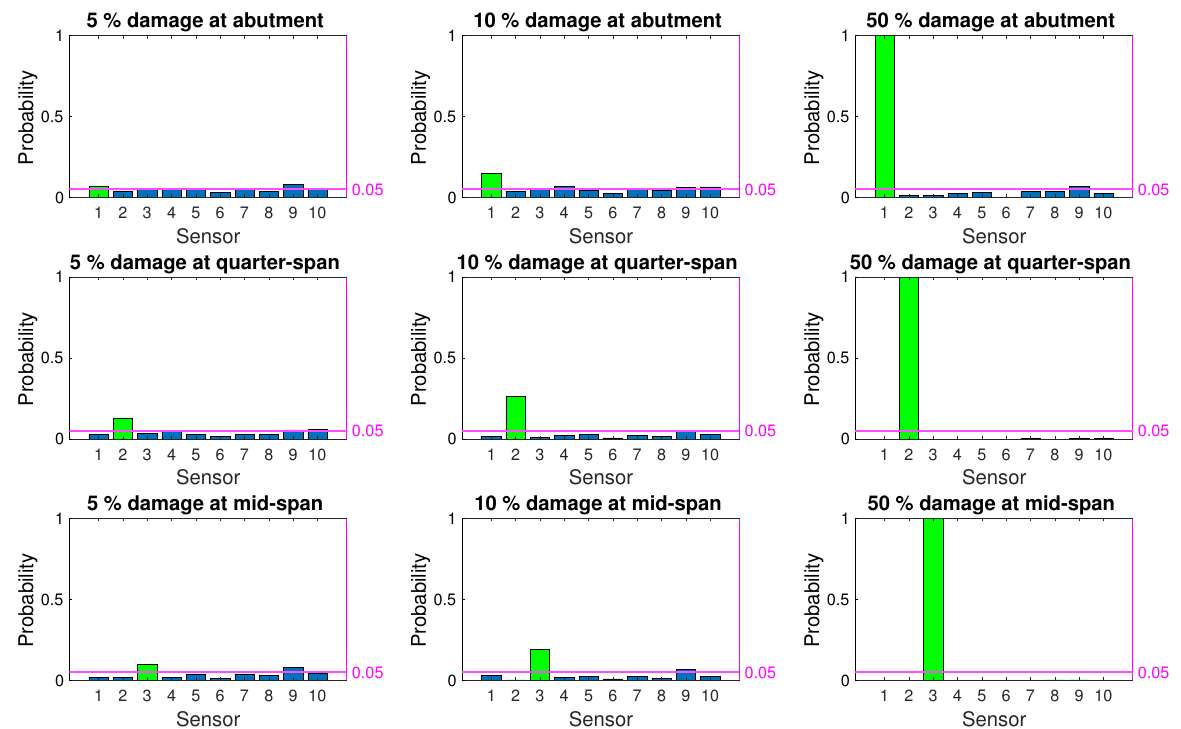
Figure 9. Probability of damage detection using modal strain energy damage indicator for 5% noise.